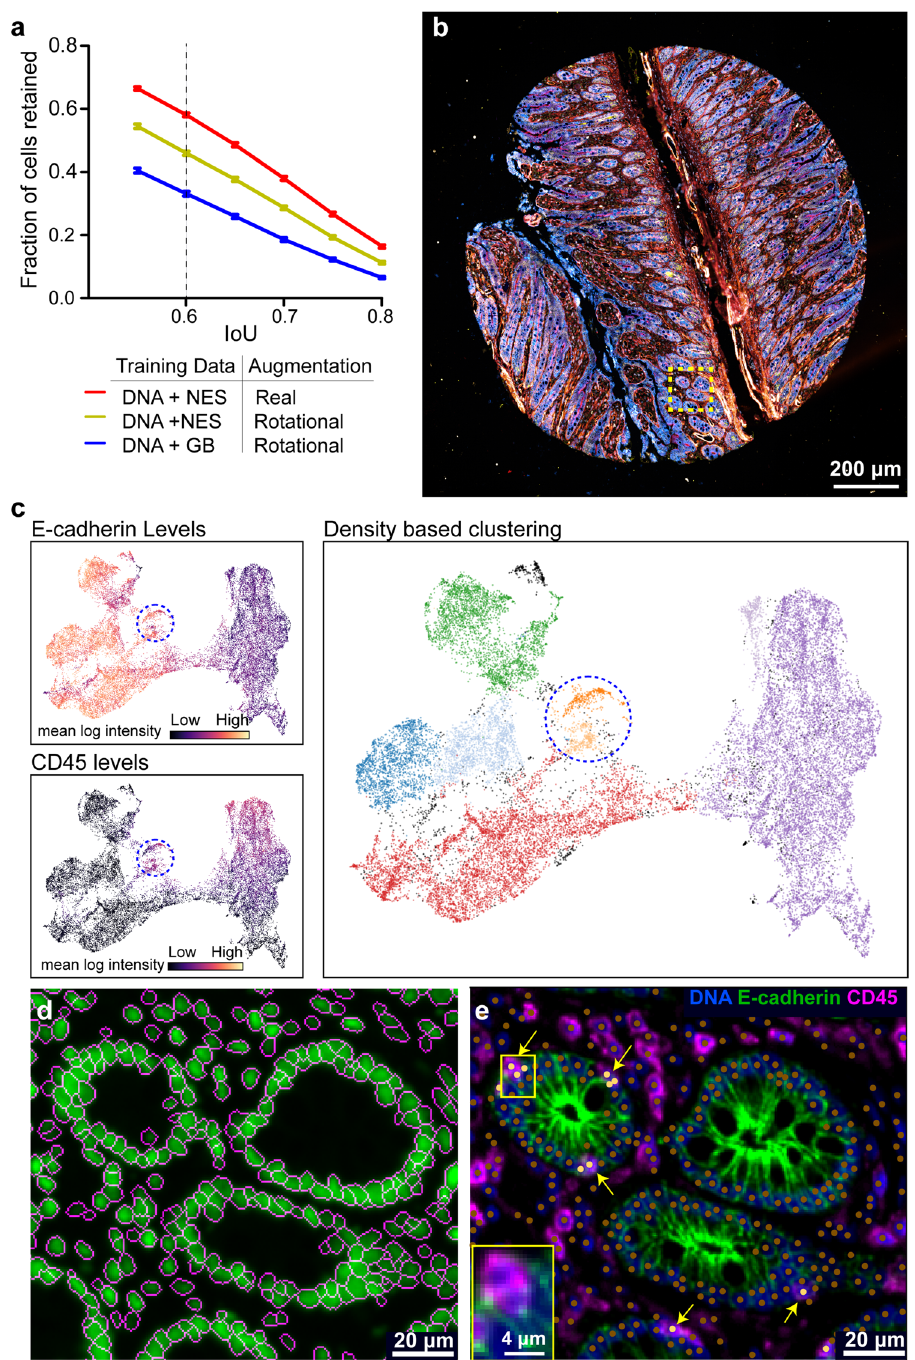
Fig. 6 Applying UnMICST models to highly multiplexed image data. a Accuracy improvement of UnMICST-U models trained with and without NES (nuclear envelope staining) as compared to DNA alone, and real augmentations as compared to computed blur (GB; Gaussian blur). To balance training dataset size, GB was substituted for NES data and computed 90/180° rotations were substituted for real augmentations. Error bars are standard error of mean. b A 64-plex CyCIF image of a non-neoplastic small intestine TMA core from the EMIT dataset. Dashed box indicates region of interest for panels ( d , e ). c UMAP projection using single cell staining intensities for 14 marker proteins (see methods). The color of the data points represents the intensity of E-cadherin (top left) or CD45 (bottom left) across all segmented nuclei. Density-based clustering using HDBSCAN identi fi ed distinct clusters (each denoted by a different color) that were positive for either E-cadherin or CD45 as well as a small number of double-positive cells (blue dashed circle). d Enlarged region of yellow dashed box from b showing segmentation mask outlines (magenta) overlayed onto DNA channel (green). e Composite image of DNA, E-cadherin, and CD45 of the same region. Nuclei centroids from segmentation denoted by brown dots. Cells positive for both E-cadherin and CD45 (from blue dashed circle in panel c are marked with yellow arrows and yellow dots. Inset: enlarged view of boxed region showing overlapping immune and epithelial